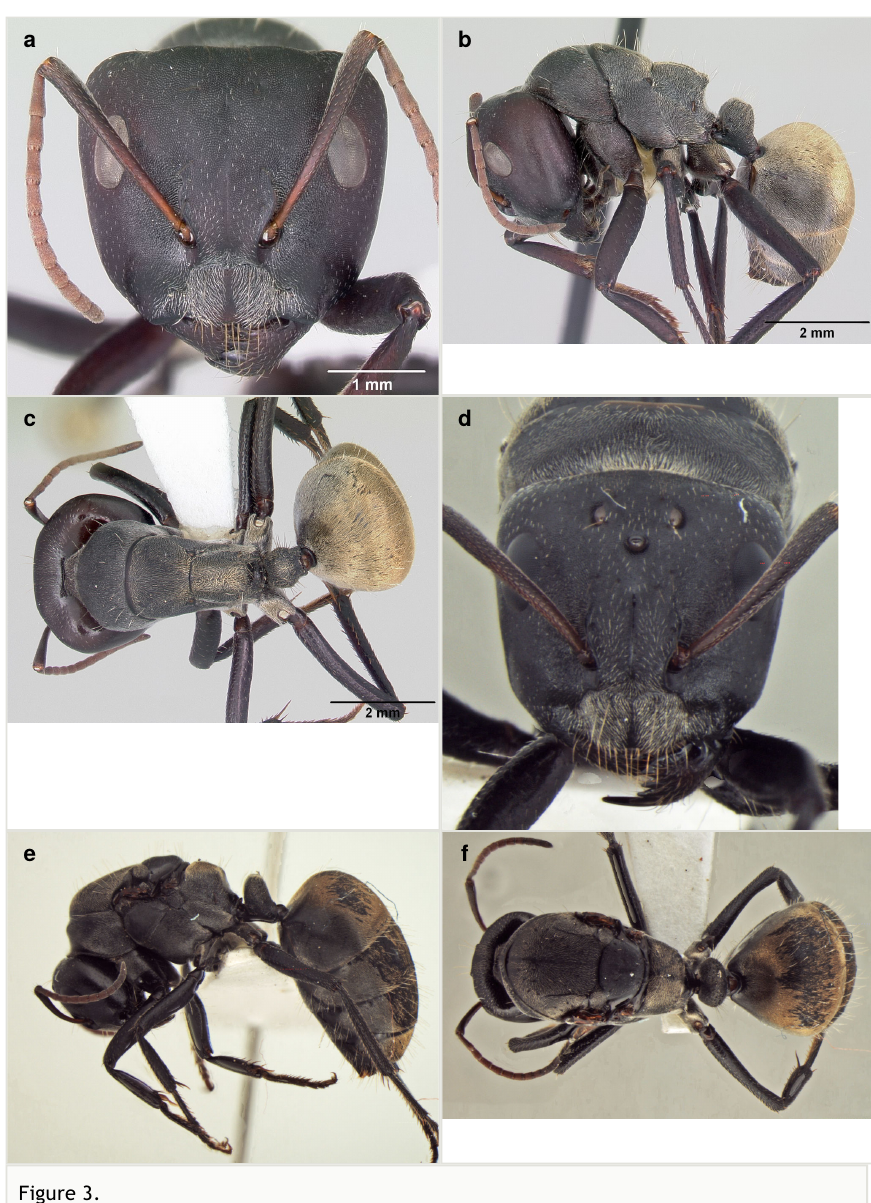
Figure 3. Camponotus sericeus (Fabricius, 1798); major worker and